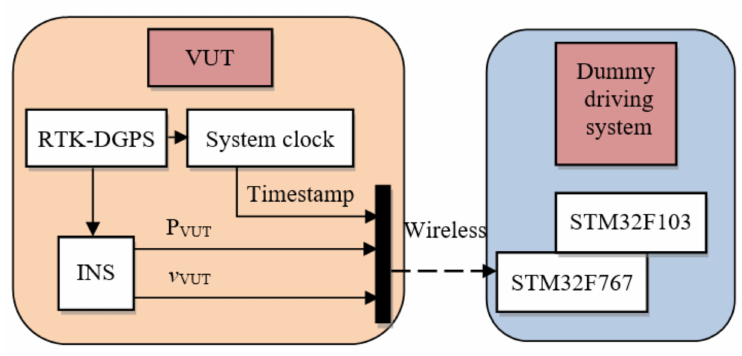
Figure 8. The position and velocity of VUT is measured and